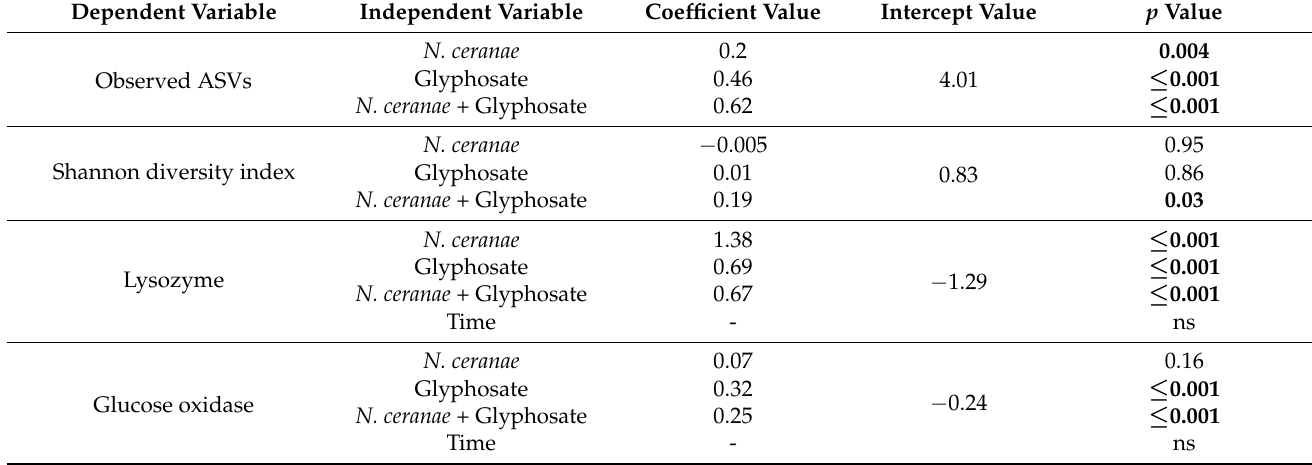
Figure 2. Impact of seven days of chronic exposure to glyphosate (10 mg/L), N. ceranae infection (100,000 spores/bee at day 0) and both factors combined on the honey bee gut microbiota: Observed amplicon sequence variants (ASVs) and Shannon Index. Ten honey bees per treatment (three/four bees per cage, from three independent cages) were individually analyzed. Results are shown as box plots, including median, 25 and 75% quartiles and outliers values. Table 1. Effect of glyphosate, N. ceranae , and both stress factors on honey bee gut microbiota, immunity, DWV infection level and syrup consumption, evaluated by generalized linear mixed models. p values under 0.05 were considered statistically significant and are shown in bold. * indicates interaction between